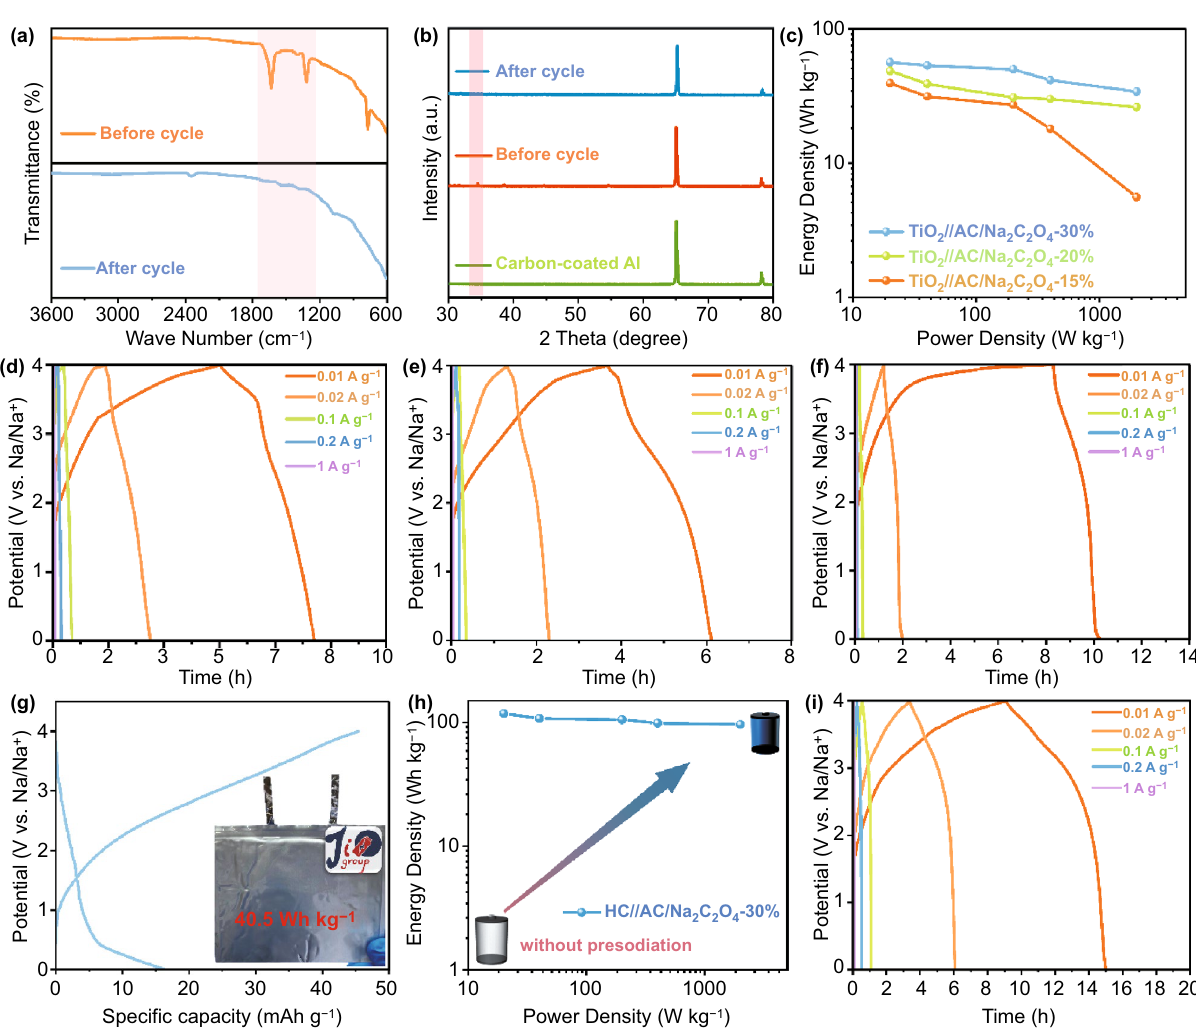
Fig. 6 a XRD patterns of AC + NCO electrodes. b FTIR results of AC + NCO electrodes. c Ragone plots of TiO 2 //AC-Na 2 C 2 O 4 with different dosage. Galvanostatic charge and discharge profiles at various current densities of d TiO 2 //AC-Na 2 C 2 O 4 -30%, e TiO 2 //AC-Na 2 C 2 O 4 -20%, and f TiO 2 //AC-Na 2 C 2 O 4 -15% SICs. g Charge and discharge profiles of pouch-type SIC at the current density of 0.1 C after activation. h The perfor- mance comparison of HC//AC without pre-sodiation SIC and HC//AC-Na 2 C 2 O 4 -30% SIC. i Galvanostatic charge and discharge profiles at vari- ous current densities of HC//AC-Na 2 C 2 O 4 -30%